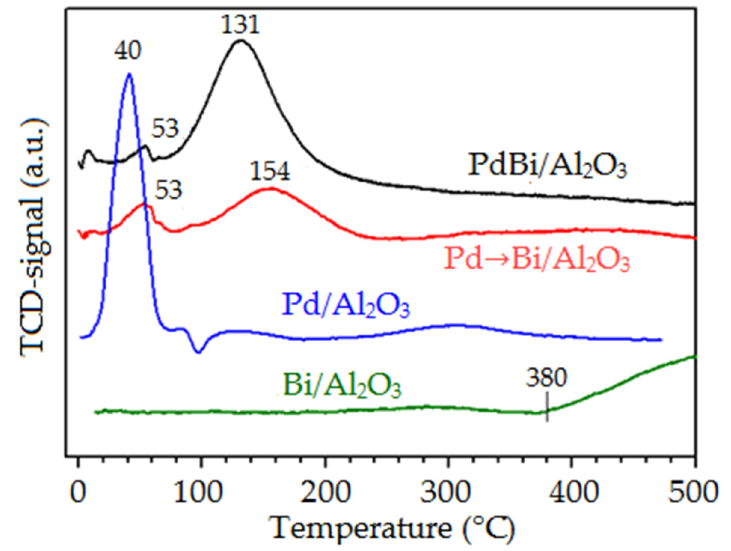
/ Al / Al → Bi / Al 2 O 3 , Pd 2 O 3 , Pd 2 O 3 , PdBi 2 O 3